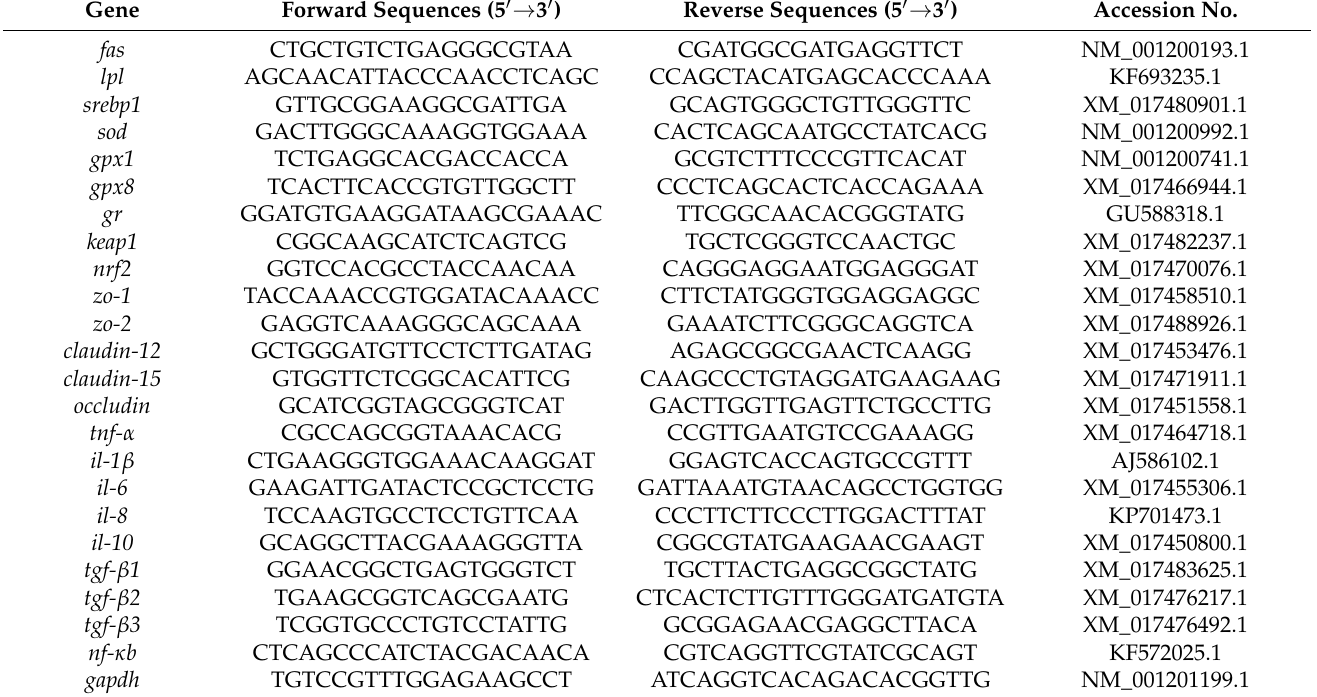
Table 2. Primers used for mRNA quantitative real-time PCR.